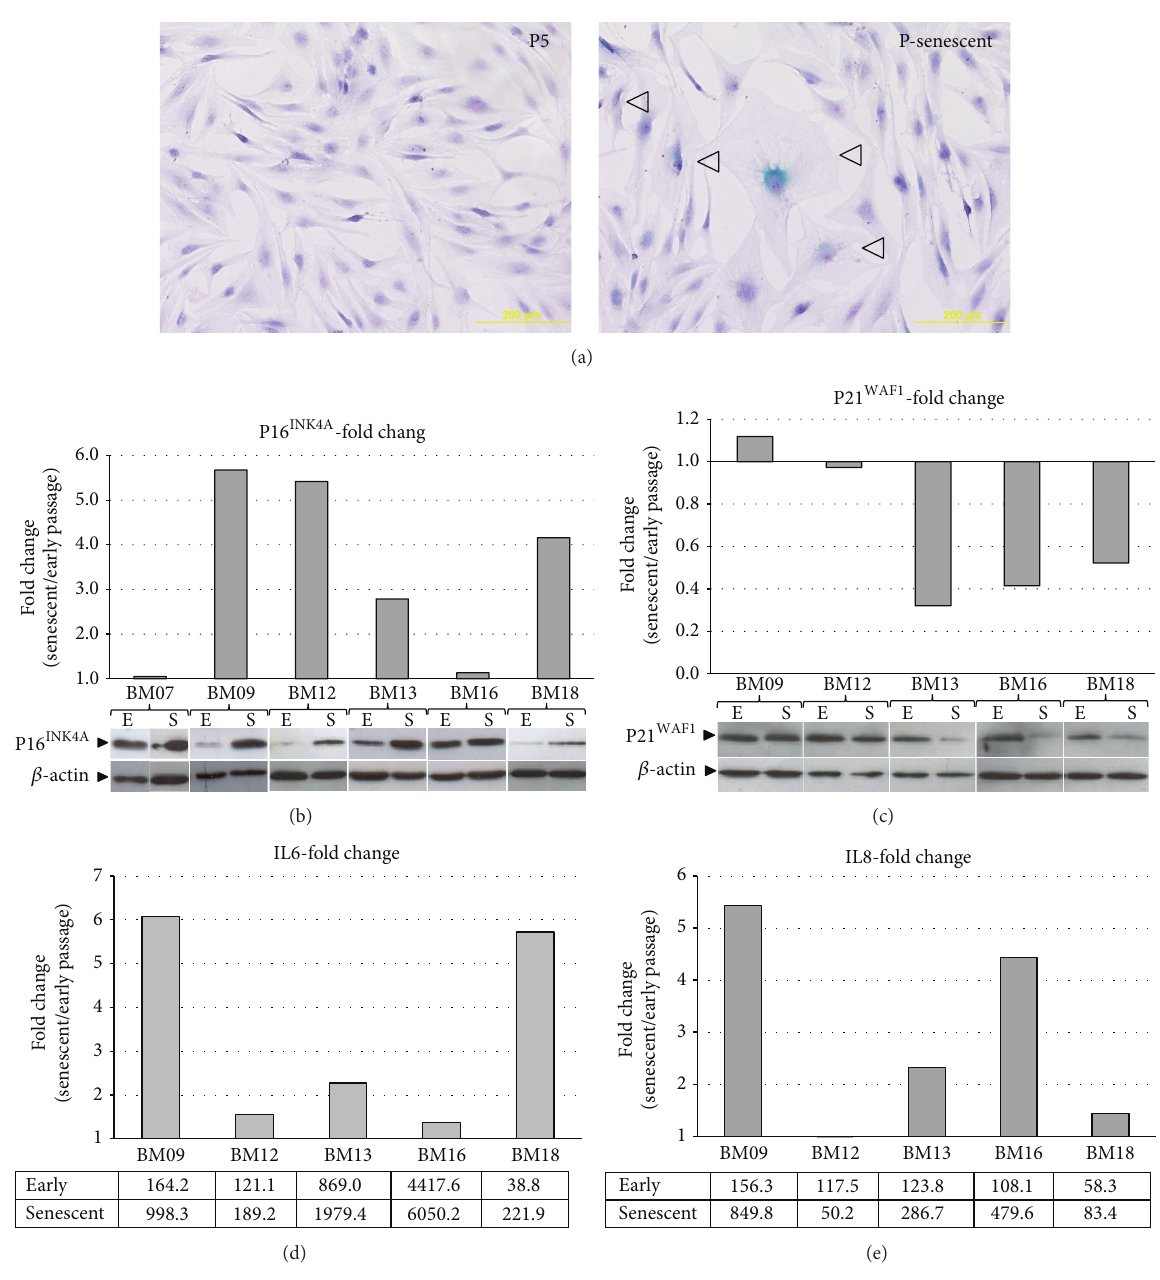
Figure 2: Morphological and molecular changes of senescent BM-MSCs. (a) Representative images of cells at early passage (5th passage) and late/senescent passage. Most early passage cells showed spindle-like morphology and few cells stained positive for the senescence- associated 𝛽 -galactosidase marker. Most senescent passage cells showed enlarged and flattened morphology and an increased number of cells stained for 𝛽 -galactosidase (arrows). (b, c) The protein expression levels of p16 INK4A and p21 WAF1 in early and late passage cells from the same donor were analyzed by western blot. Band intensities were densitometrically evaluated and p16 INK4A and p21 WAF1 protein levels were quantified and normalized to the corresponding 𝛽 -actin levels (loading control). Subsequently, the normalized values obtained were then used to calculate the fold change in expression between late and early passage cells (bar graphs). These results are representative of three independent experiments. Most senescent cells showed increased p16 INK4A expression levels. On the contrary, most senescent cells showed decreased p21 WAF1 expression levels. (d, e) The levels of secreted IL6 and IL8 in early and late passage cells from the same donor were determined using a CBA proinflammatory kit. Values obtained (expressed as pg/mL, bottom) were then used to calculate the fold change in secreted protein levels between late and early passage cells (bar graphs). These results were obtained in triplicate and are representative of two independent experiments. Most senescent BM-MSCs showed enhanced secretion of these proinflammatory